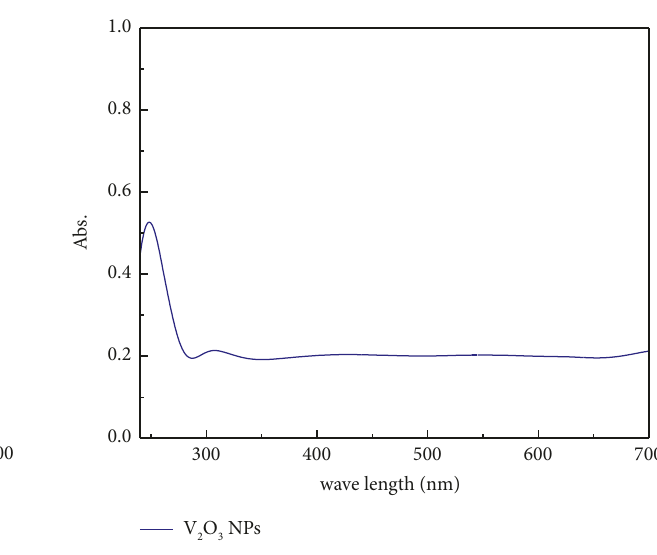
Figure 2: UV-Vis spectrum of Nd